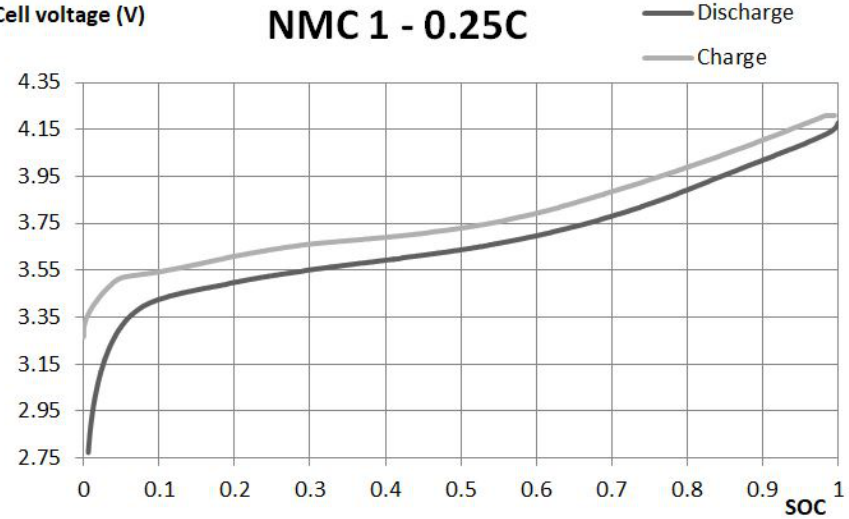
Figure 1. Charge and discharge voltages at 0.25 C in dependence of SOC for the NMC1 battery. Charge/discharge curves of Li-NMC differ significantly from other types of lithium